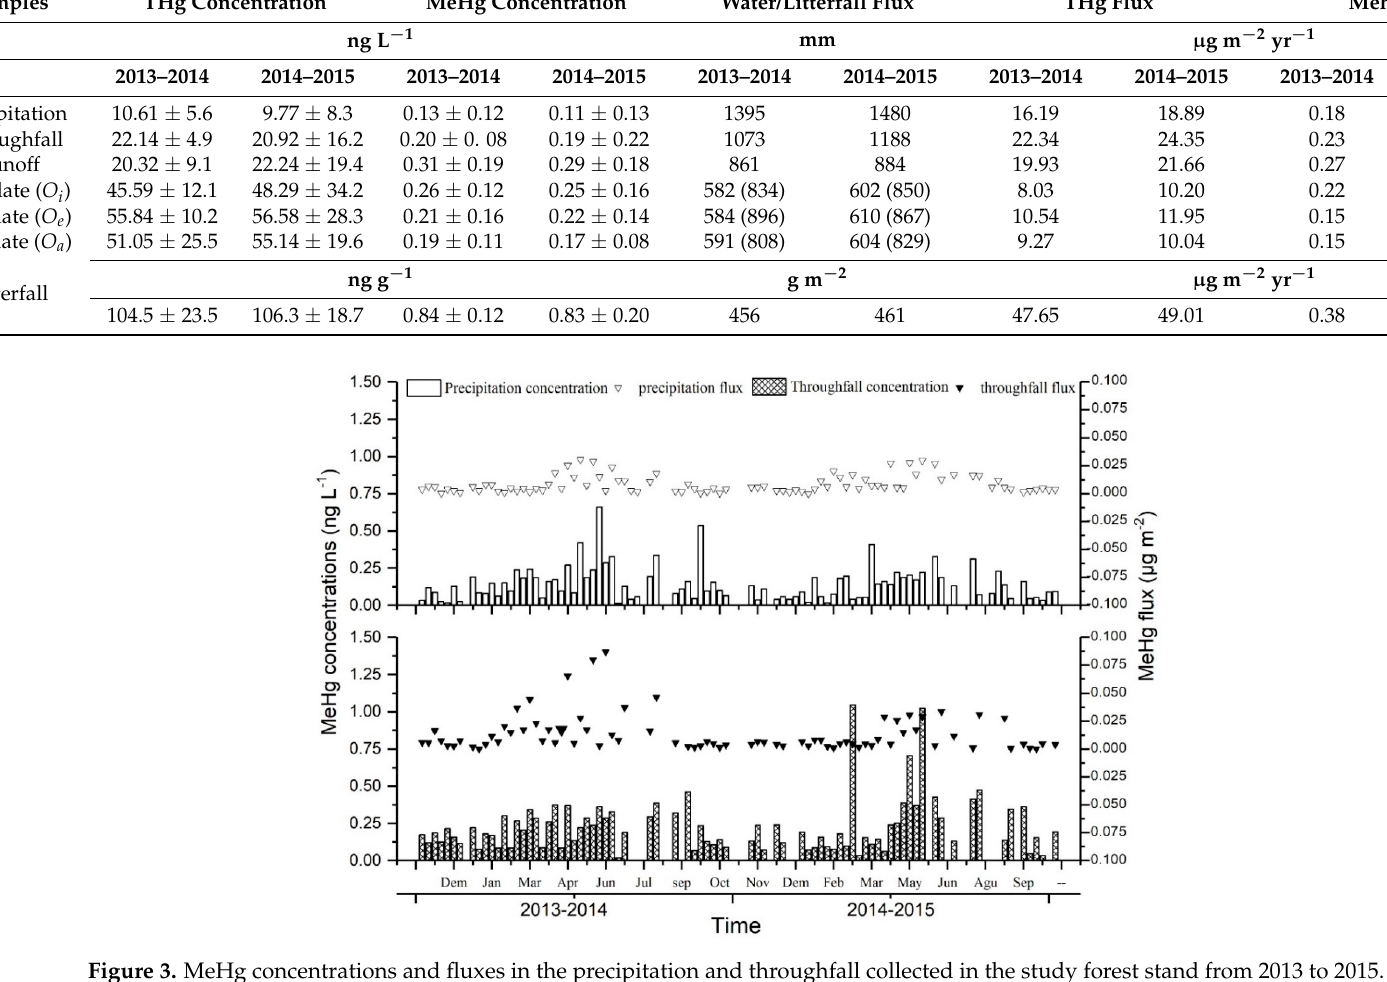
Table 2. The corrected concentrations and fluxes of THg and MeHg in the throughfall, litterfall, runoff, forest-floor percolates and water during the sampling period from 2013 to 2015.